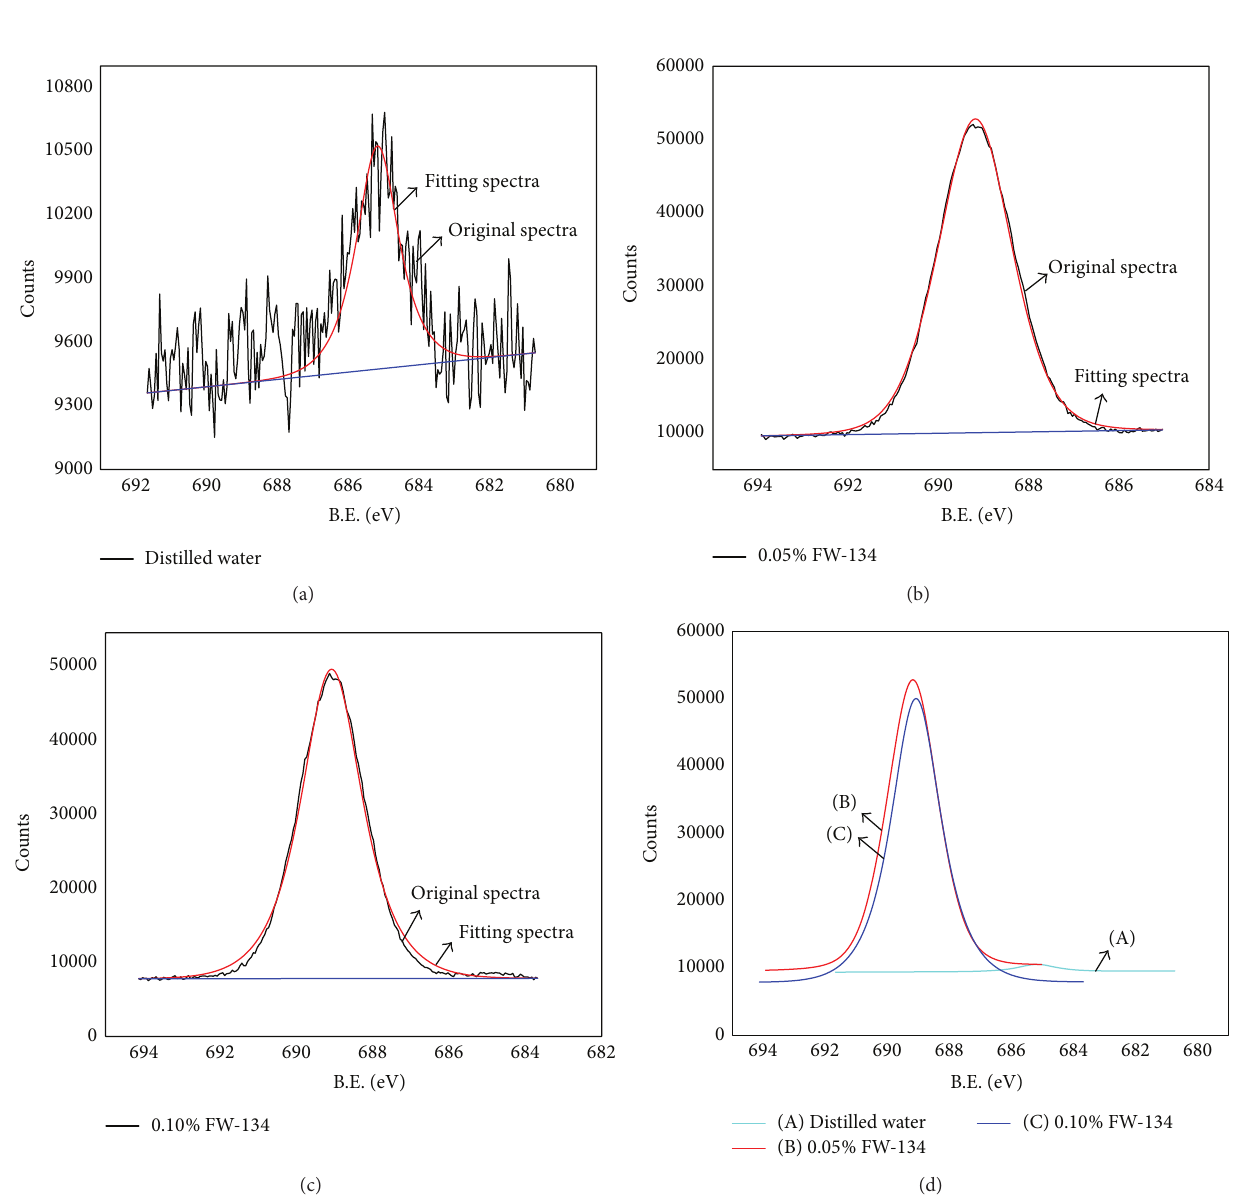
Figure 4: XPS C1s spectra of sample systems adsorbing FW-134 and contrast